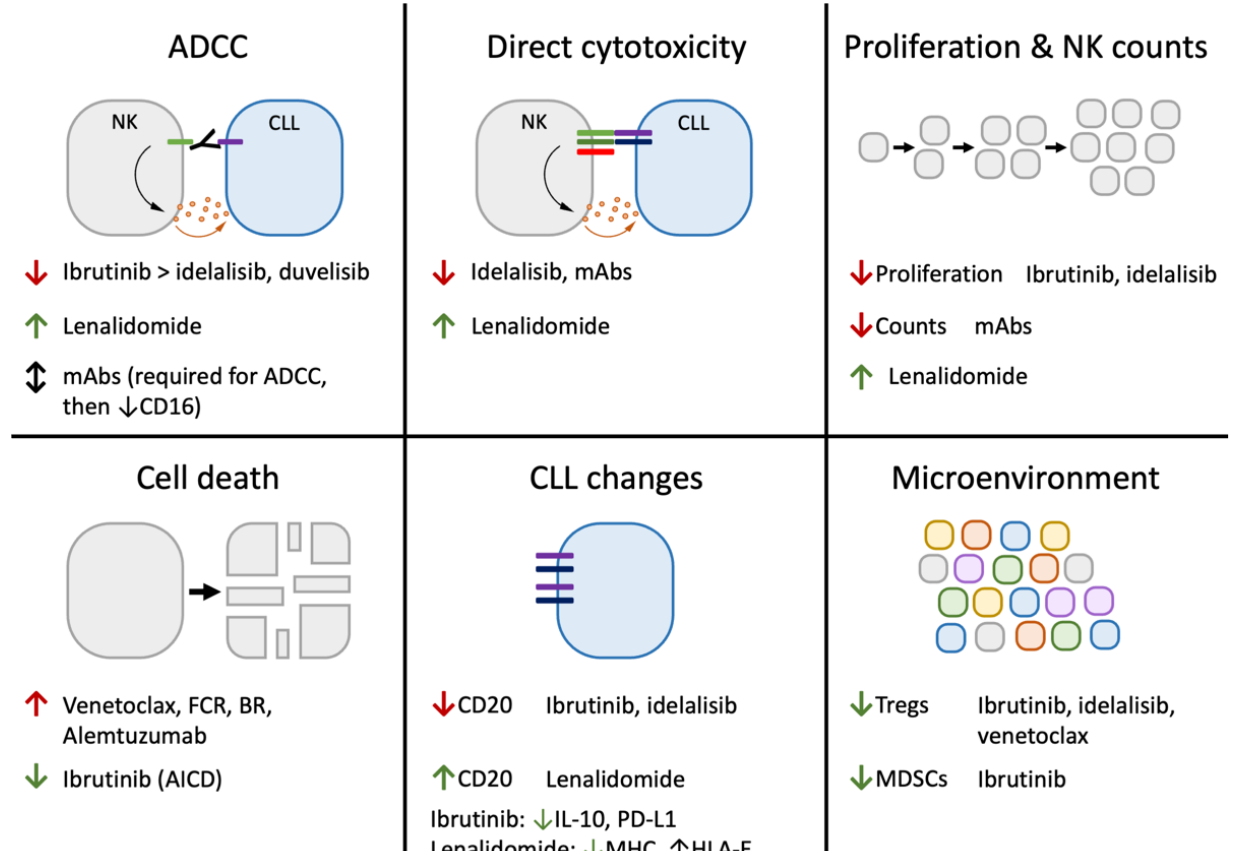
Figure 3. Key effects of CLL therapeutics on NK function. Current CLL therapeutics have been demonstrated to affect natural killer cells in a variety of ways. This includes directly increasing or decreasing NK cytotoxic function, proliferation, and death. It also includes indirect methods via these therapeutics’ effects on CLL and other cells in the microenvironment. Changes are listed as increases ( ↑ ) or decreases ( ↓ ), and are color-coded according to whether the measured change is expected to increase (green) or decrease (red) anti-leukemia NK activity.